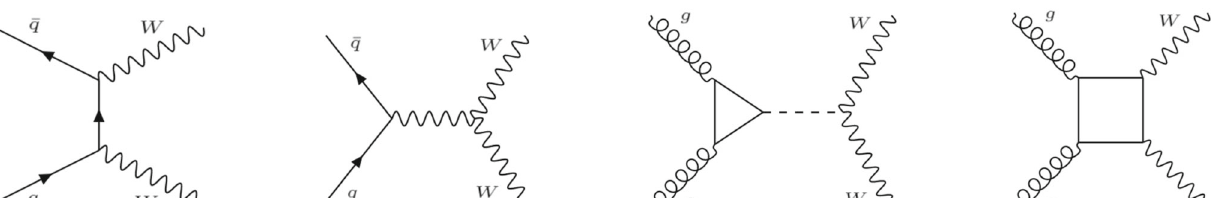
Fig. 8 Representative Feynman diagrams for opposite-sign W ± W ∓ diboson production, where the first two diagrams correspond to leading order processes while other two to gluon-initiated loop-induced